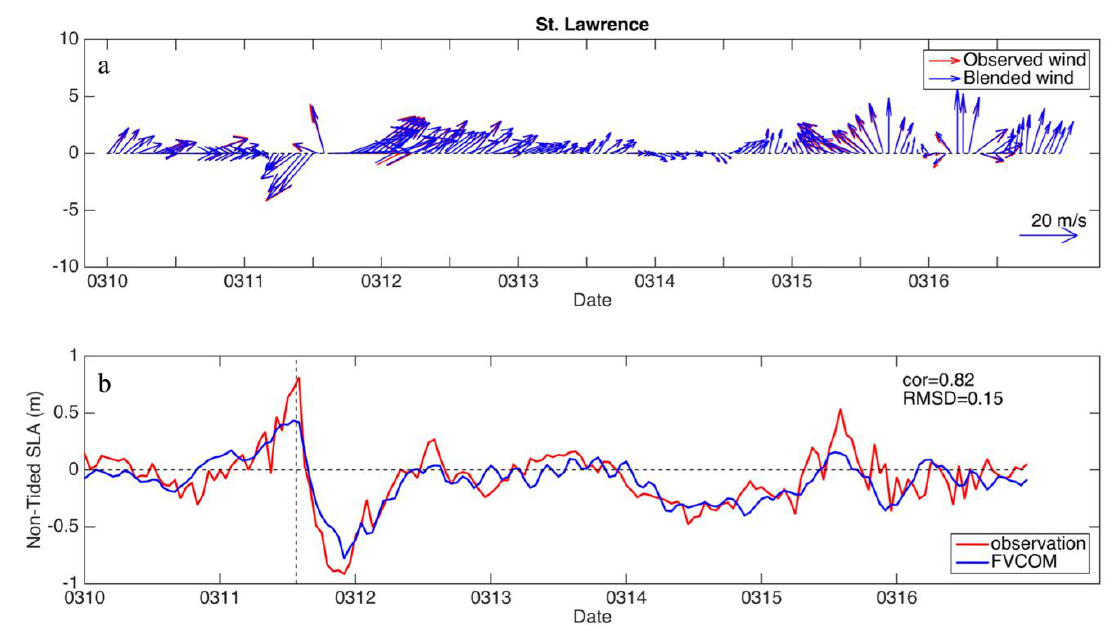
Figure 13. ( a ) Hourly wind vectors (m s − 1 ) from weather station observations (red) and reconstruction (blue) at SL from 10 to 16 March 2017. ( b ) Time series of the non-tidal sea level anomalies (m) from observations (red) and model results forced by the reconstructed wind fields (blue) at SL. The horizontal black dashed lines denote non-tide SLA = 0 m. The vertical black dashed lines denote the time of landfall.